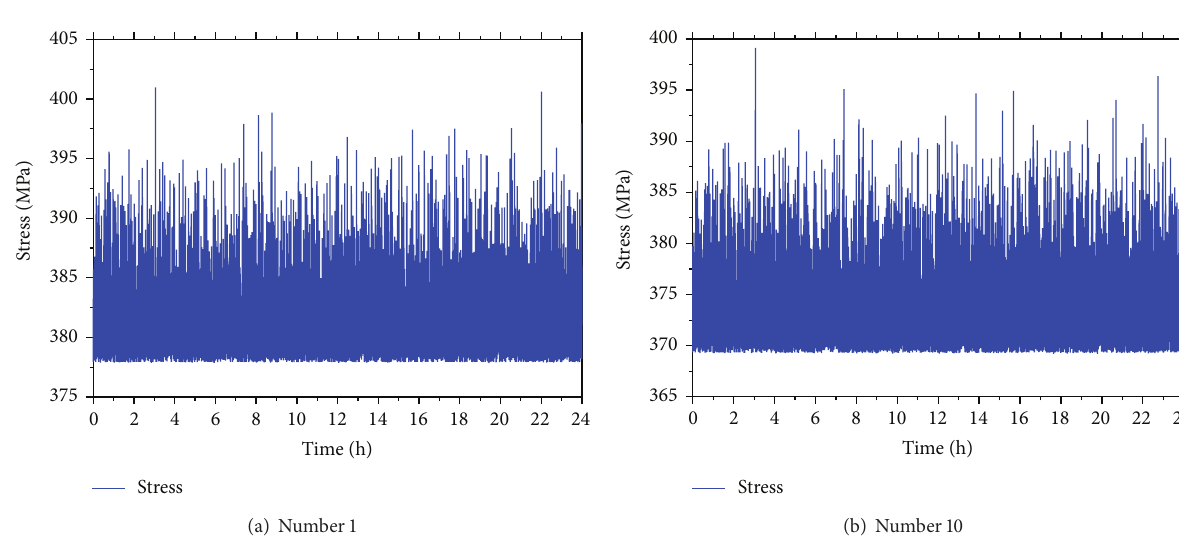
Figure 14: Stress processes for the